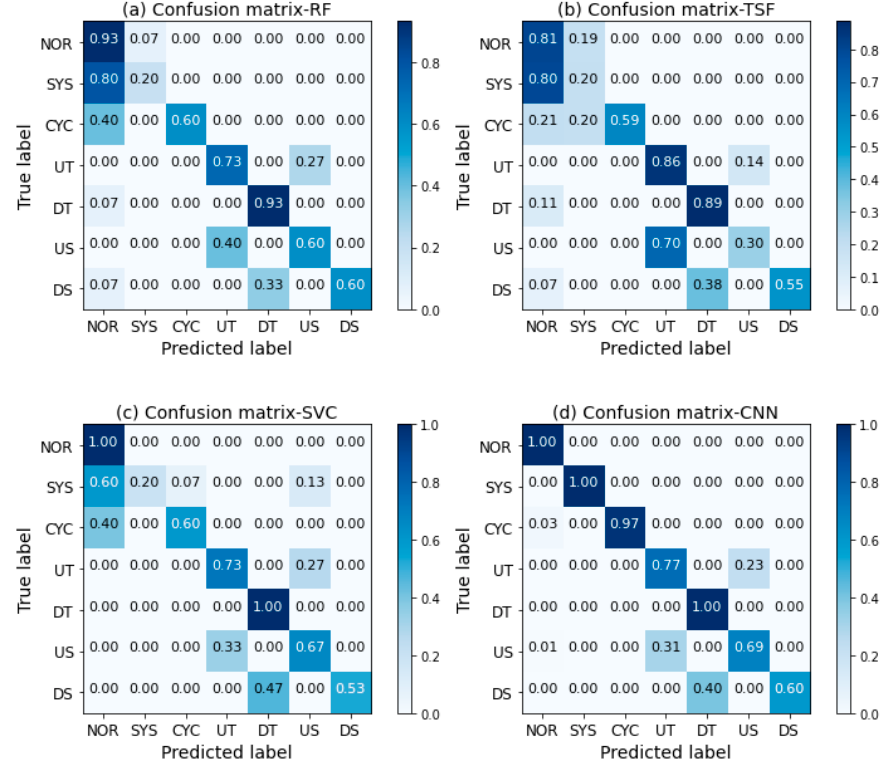
Figure 12. Confusion matrices obtained from experiment 1. Each row represents a true class, while each column represents a predicted class.